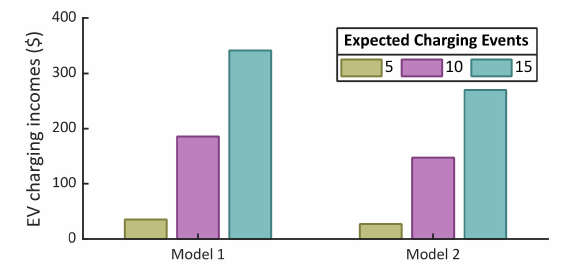
Figure 9. The value of the objective function for various scenarios.